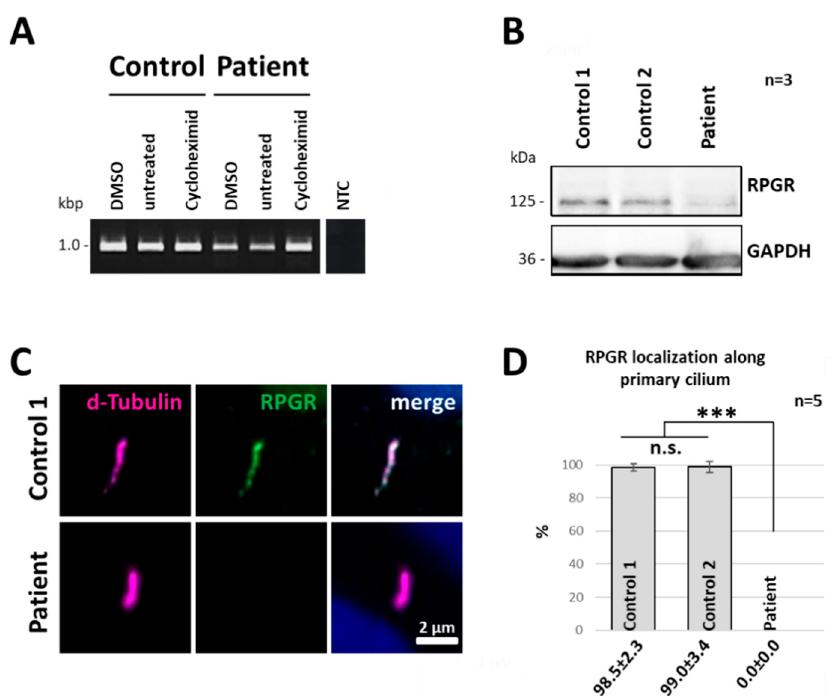
Figure 4. Patient-derived dermal fibroblasts lack RPGR at primary cilia. ( A ) Influence of NMD on RPGR transcript levels in patient-derived and control fibroblasts. Cells were treated with 100 µg/mL cycloheximide (CHX) for 4 h. DMSO-treated and untreated cells were used as controls. RT-PCR analyses included exon 9 to 11 of the RPGR transcript and were performed using equal amounts of RNA in each sample. NTC: non-template control. ( B ) Western blot analyses showed a strongly reduced level of RPGR protein expression (125 kDa) in the patient-derived cell line. Residual signals in the patient might correspond to basal spontaneous read-through. In contrast, RPGR was detected in two unaffected control cell lines. GAPDH (36 kDa) was used as a loading control. Molecular weight is indicated in kDa. ( C ) Immunocytochemistry (ICC) of RPGR at primary cilia. Control cells showed a dot-like expression pattern of RPGR (green) along the axoneme of the cilium (magenta). In the patient-derived fibroblasts, RPGR expression was not detected. D-tubulin was used as a marker for the primary cilium. ( D ) Quantification of cilia showing RPGR along the ciliary axoneme. A highly significant reduction of RPGR signals at primary cilia was detected in the patient-derived cell line. More than 90% of the control cells showed RPGR at the primary cilium, whereas RPGR was not detected along the cilium in the patient cell line (among 250 primary cilia, none showed RPGR staining). Experiments were independently repeated 5 times (n = 5). Error bars represent standard deviation. Asterisks: significant differences; n.s: non-significant, ***: p ≤ 0.001.